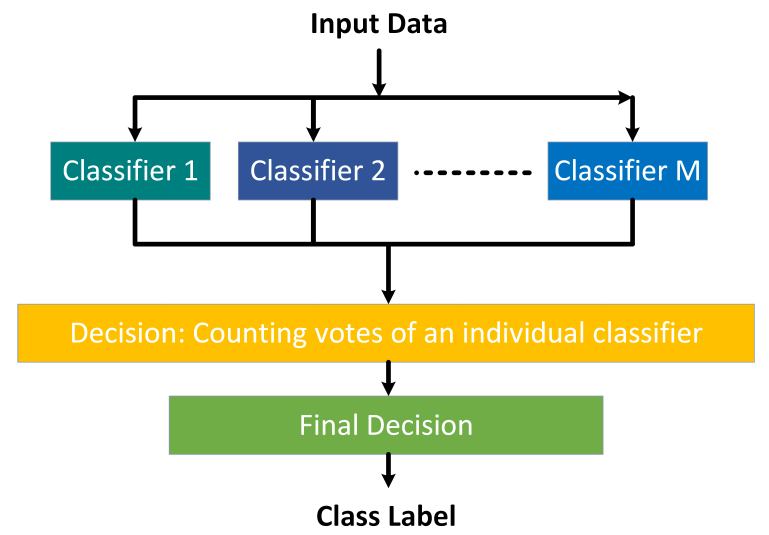
Figure 4. An ensemble classifier based on a hard-level